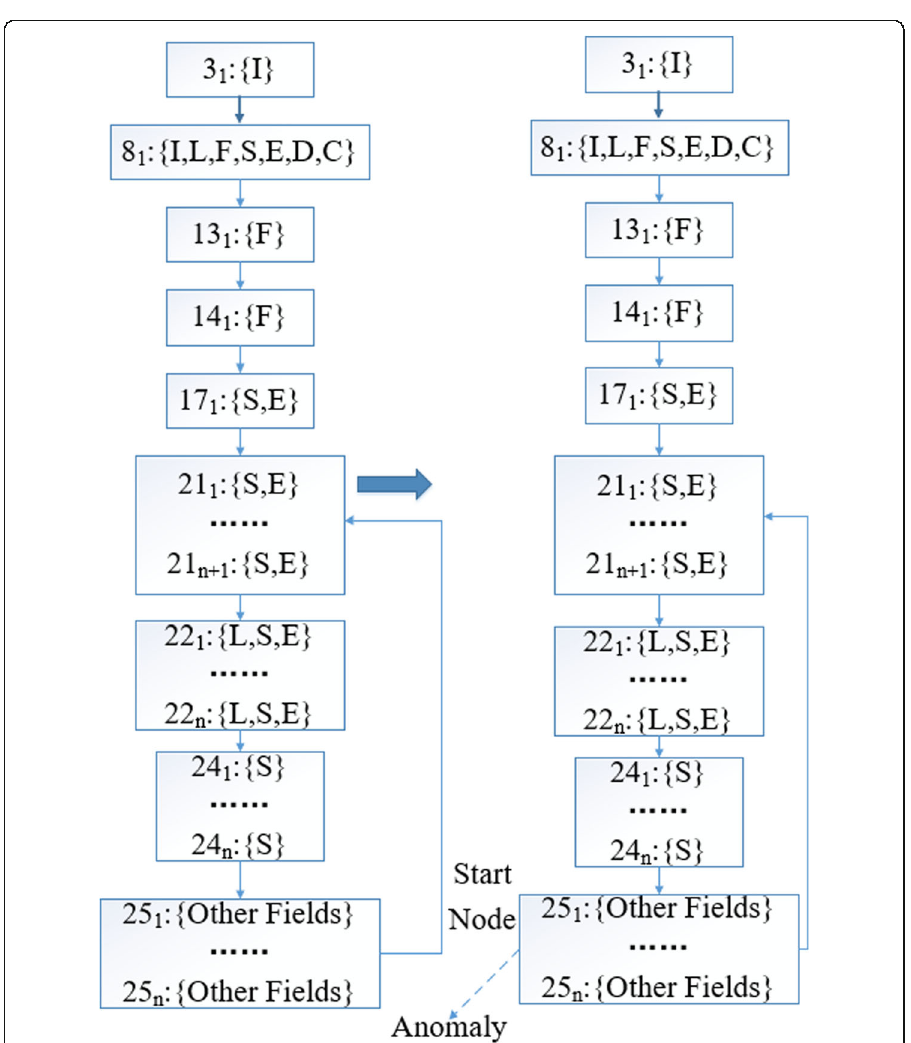
Fig. 8 Control flow diagram and execution paths of the second